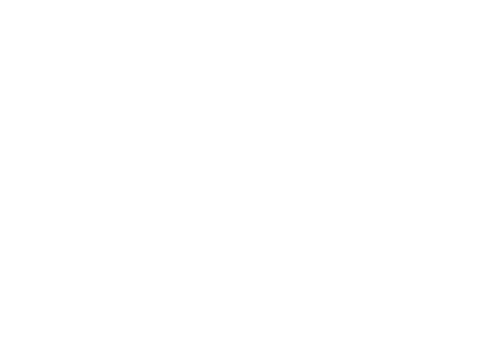
Figure 7. Response of the sensor under different dilution ratios and comparison with the PPS. The BC concentration varied between 30 and 80 µ g/m 3 depending on the